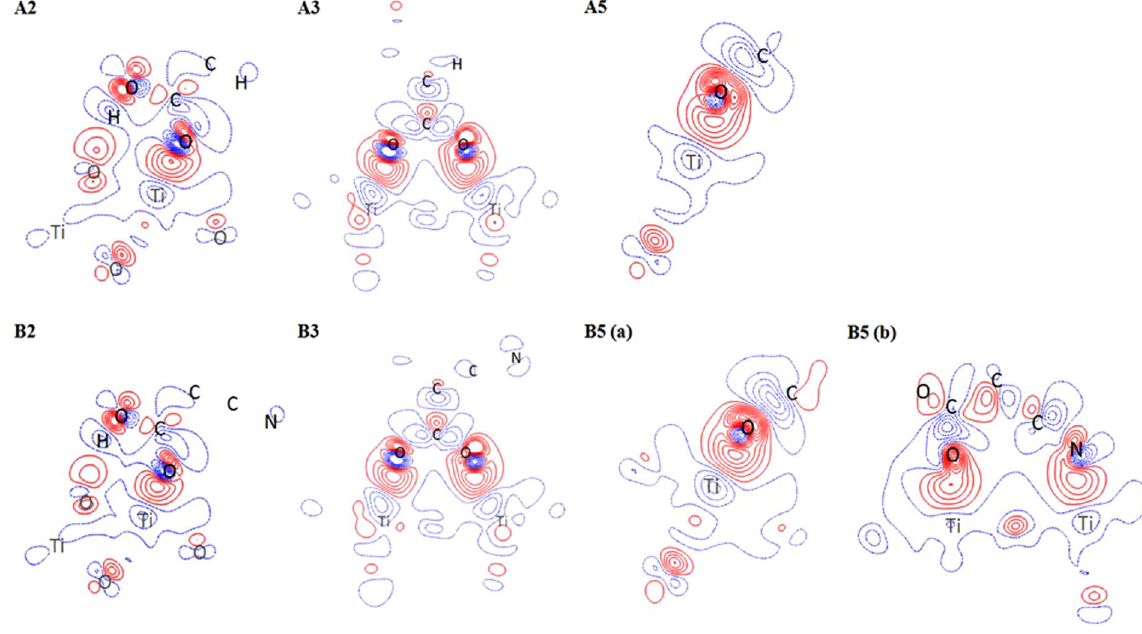
Figure 3. The electron density difference plot of configurations 2, 3, and 5 for both TP-COOH (A) and TP- CN COOH (B)